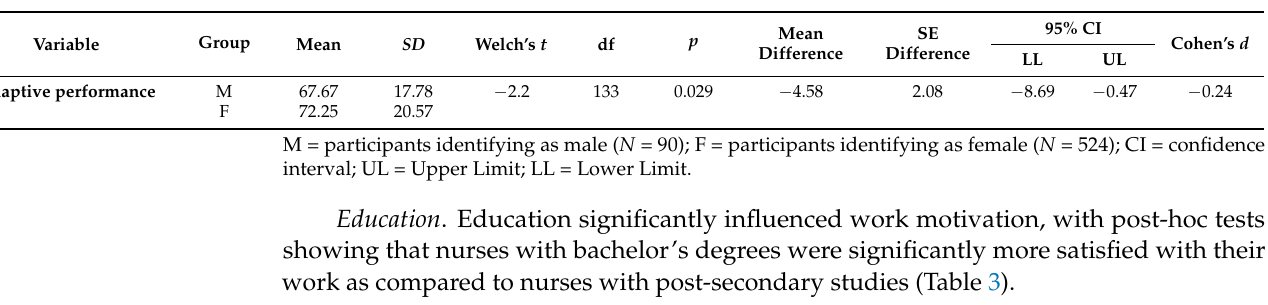
Table 3. Differences in variables of interest according to participants’ level of